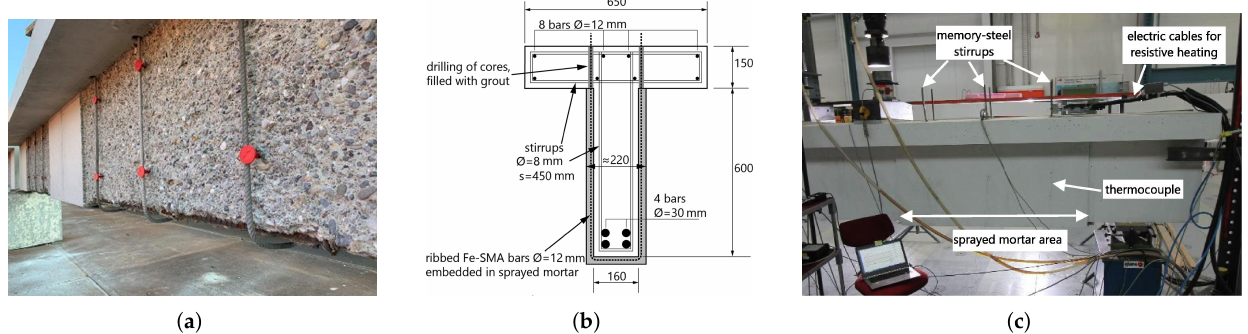
Figure 10. ( a ) Employment of the SMA stirrups on the RC beam; ( b ) cross section of the reinforced RC beam; ( c ) the test installation [62].